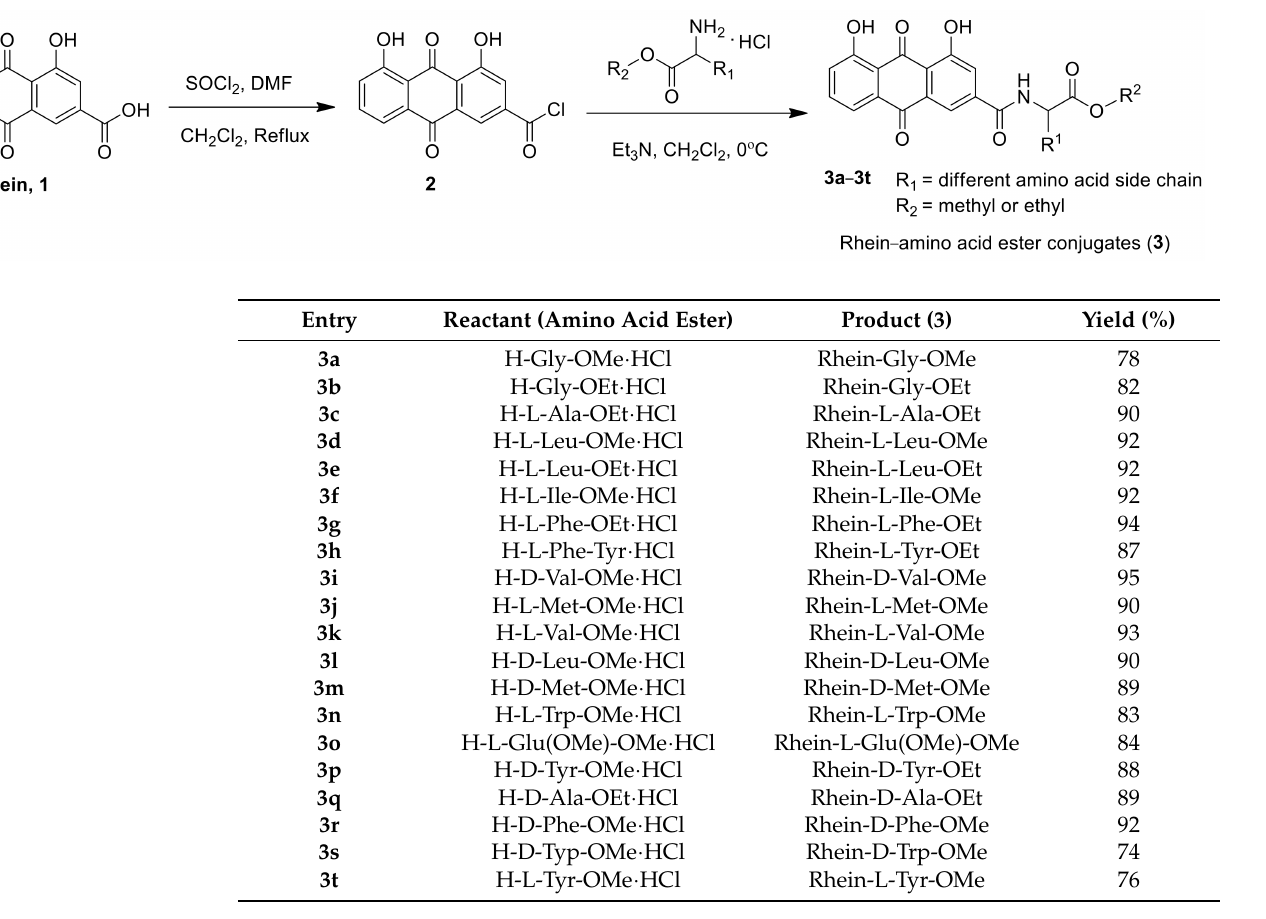
Figure 2. Preparation of rhein–amino acid ester conjugates 3a–3t .